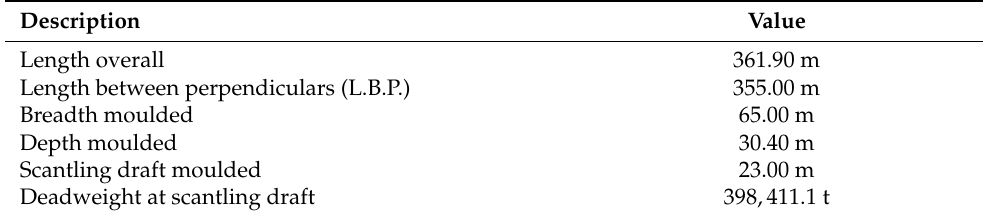
Table 1. Principal particulars of ‘PACIFIC VISION’, from